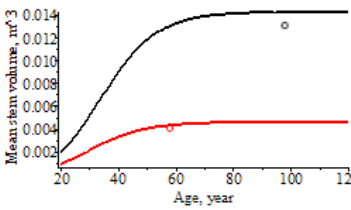
Figure 7. Dynamics of the mean tree volume, over time, for two randomly selected stands from the validation dataset and mixed-effect scenario. Black color—the first stand; red color—the second stand; circles—the observed values.